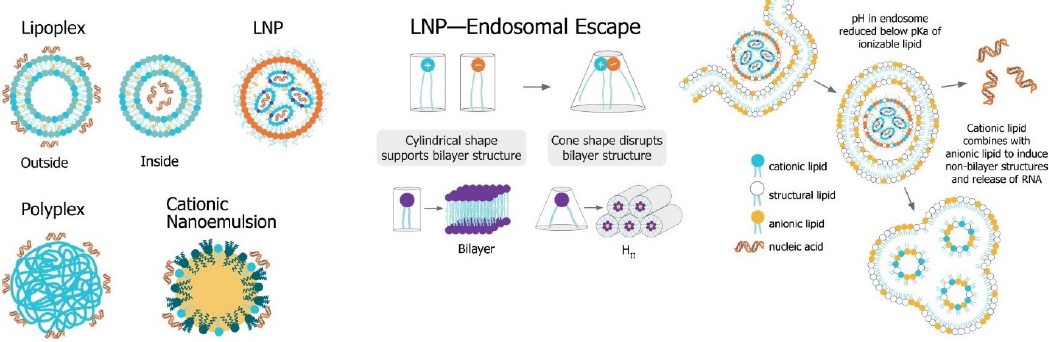
Figure 6. Non-viral saRNA delivery systems. Lipid-, polymer-, and emulsion-based delivery systems all use cationic groups to mediate condensation of the anionic RNA as well as delivery across the cell membrane. LNP systems, which have been found to be the most potent vaccine formulatinos, utilize a pH-sensitive ionizable cationic lipids and are taken up in cells through receptor-mediated endocytosis. In the endosome, the lower pH environment ionizes the cationic lipids, which then interacts electrostatically with anionic lipids in the endosomal membrane. These ion pairs cause a phase tran ‐ sition into a porous hexagonal phase (H II ) that disrupts the endosome and facilitates release of the RNA into the cytoplasm.